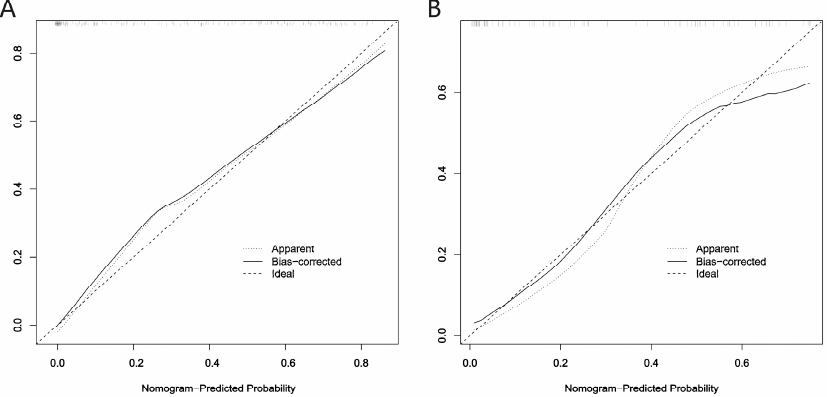
Figure 4. Calibration curves for the prediction model of CDKN2A/B homozygous deletions. ( A ) Training set and ( B ) Validation